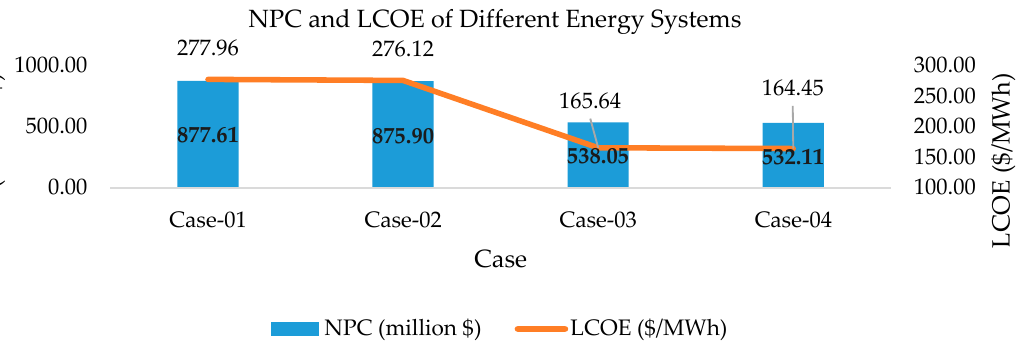
Figure 2. Comparison of NPC and LCOE of Different Energy Systems.